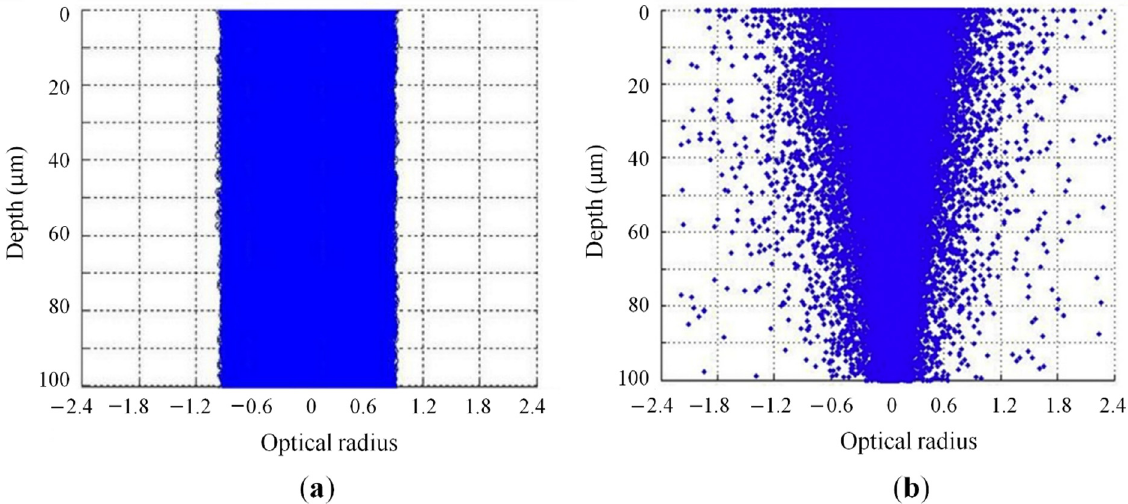
Figure 7. Simulation results of photon propagation inside a polymeric powder bed: ( a ) radiative model without scattering (the laser was considered a volumetric heat source, as proposed by De- fauchy [80]); ( b ) Monte Carlo method with scattering. Reproduced with permission from [81].